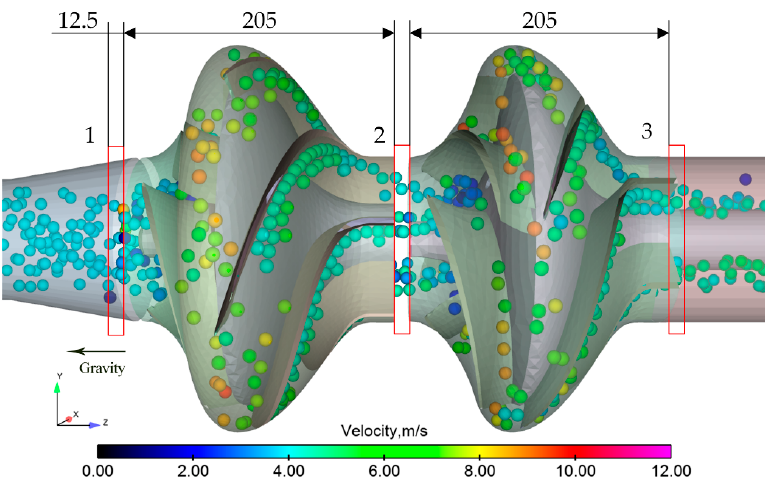
Figure 9. Distribution and velocity of particle groups in the entire slurry transport pump at 1.2 s.